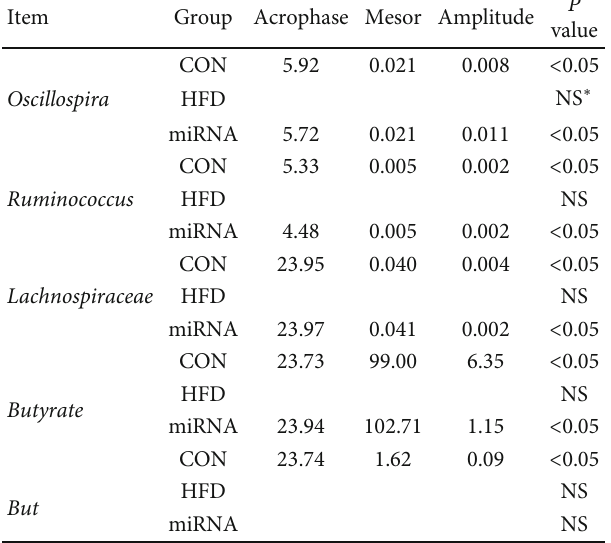
Table 4: Mesor, amplitude, and acrophase of gut microbiota, butyrate content, and But